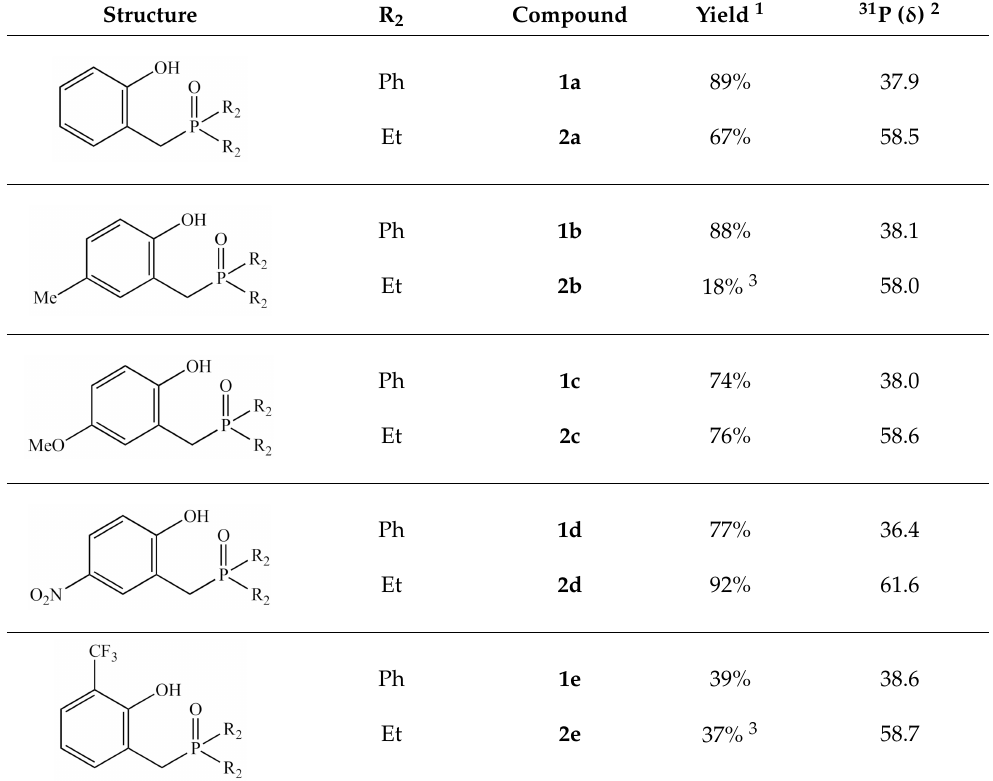
Table 3. Library of 2-HOBPOs synthesized and